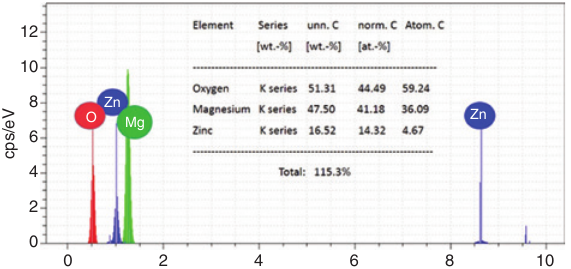
Figure 2: Energy dispersive X-ray spectrums after calcination at 800 °